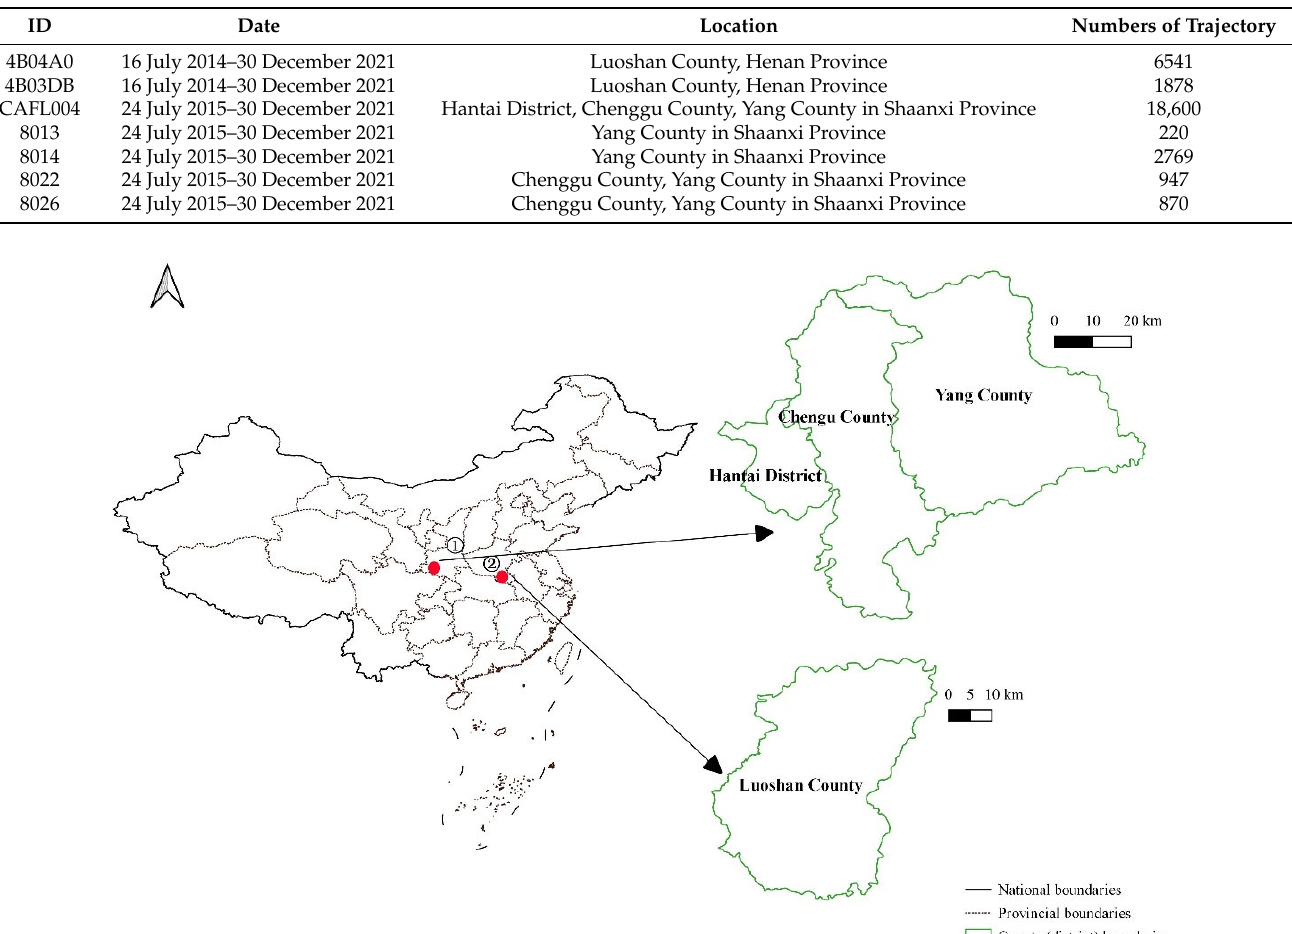
Table 1. Crested Ibis Data Sheet. ID is the number of each individual; date is the time range of each individual’s data recording; numbers of trajectory is the number of trajectory points for each individual.